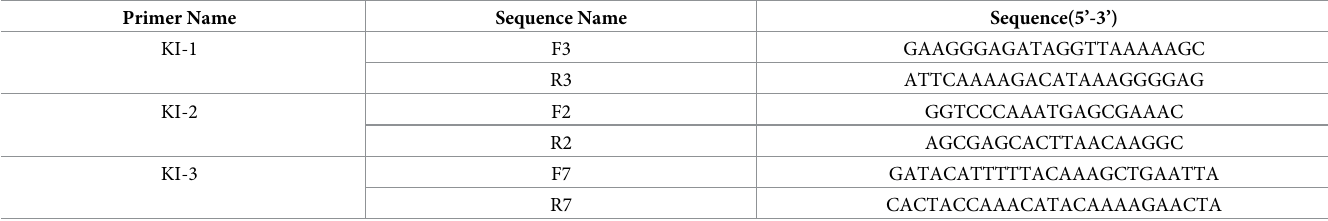
Table 4. Knock-in primers and corresponding